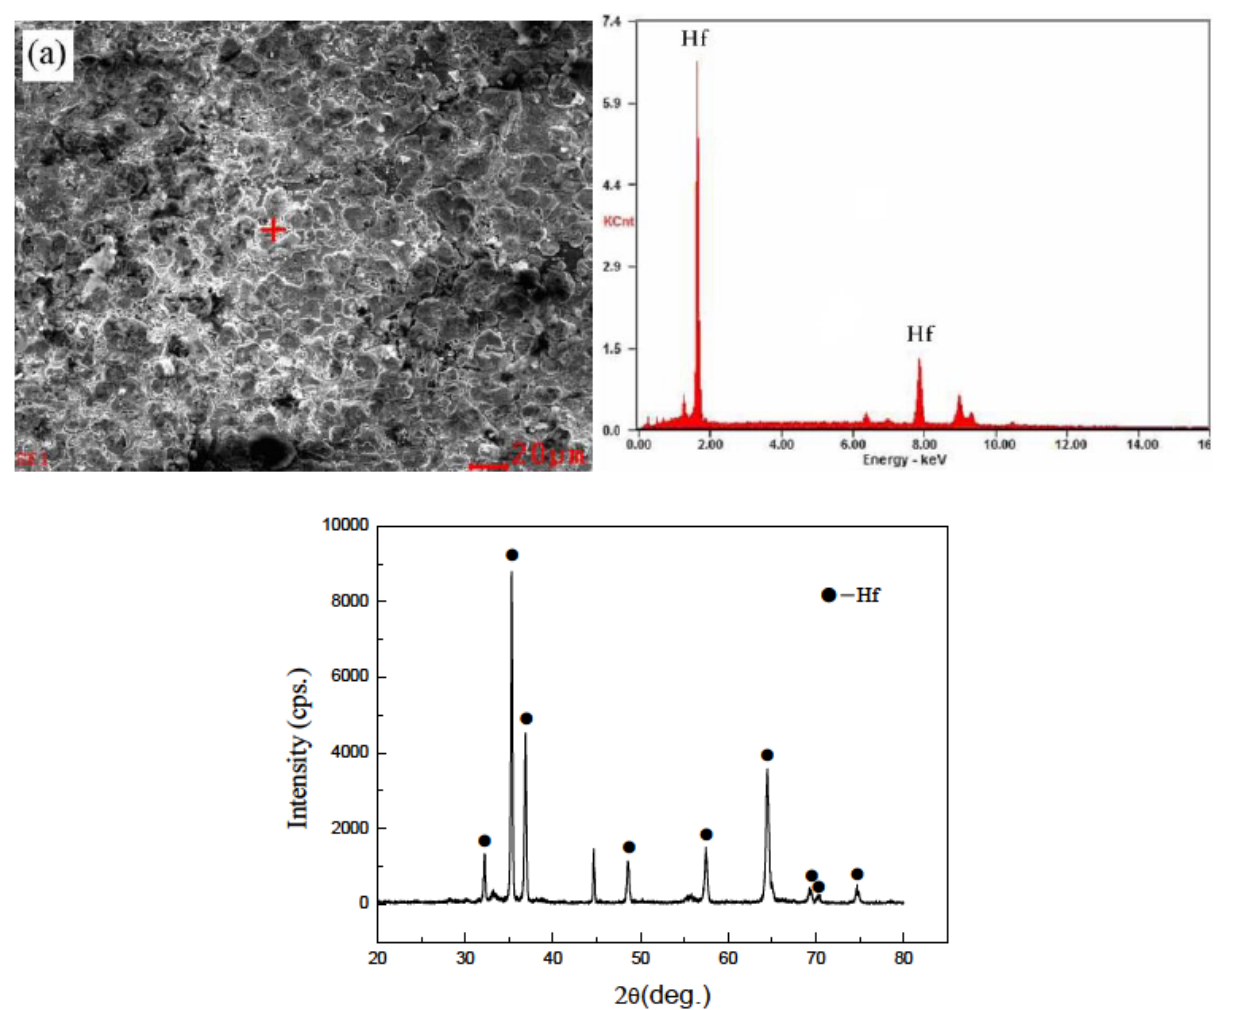
Figure 8: EDS and XRD of Hf electrodeposited layer